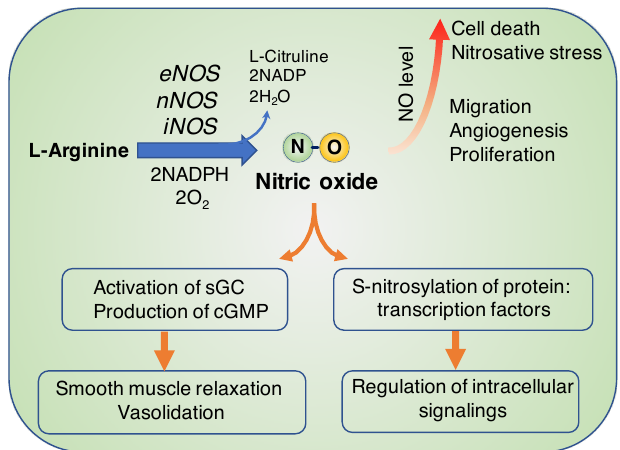
Figure 1. Biosynthesisofnitricoxide(NO)moleculeanditsbiofunctionalactivities. Inthebiologicalsystem, NO is synthesized from the oxidation of L-arginine (L-Arg) by three nitric oxide synthases (NOSs), namely endothelial (eNOS), neuronal (nNOS), and inducible (iNOS) isoforms. Under physiological conditions, NO activates soluble guanylate cyclase (sGC) to produce cyclic guanidine monophosphate (cGMP), which plays critical roles in relaxation and vasodilation of smooth muscle cells. Additionally, NO causes the S-nitrosylation of proteins, such as transcription factors (such as NF- κ B, HIF-1 α , EGR-1, etc.), which leads to the downregulation or upregulation of important intracellular signaling pathways